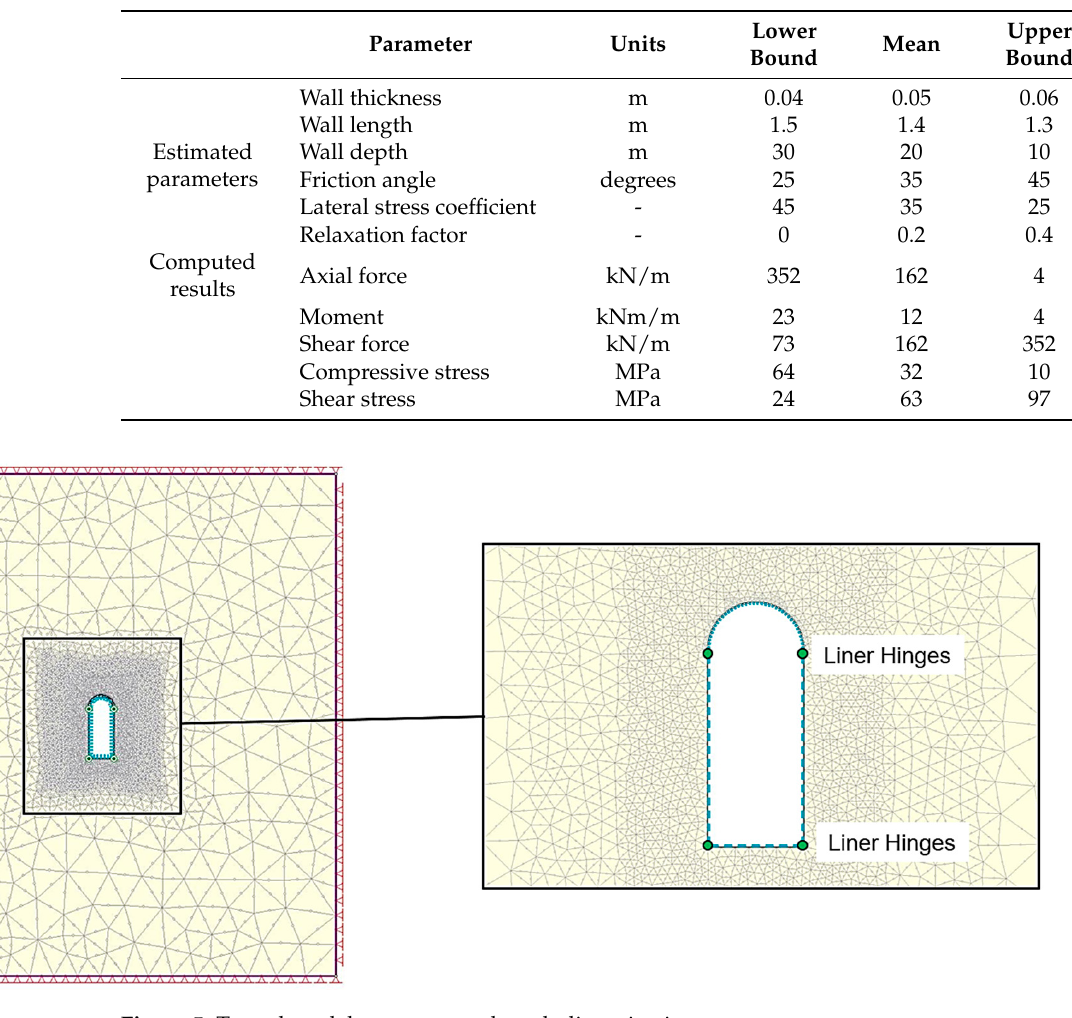
Table 3. Numerical model estimated parameters and results.